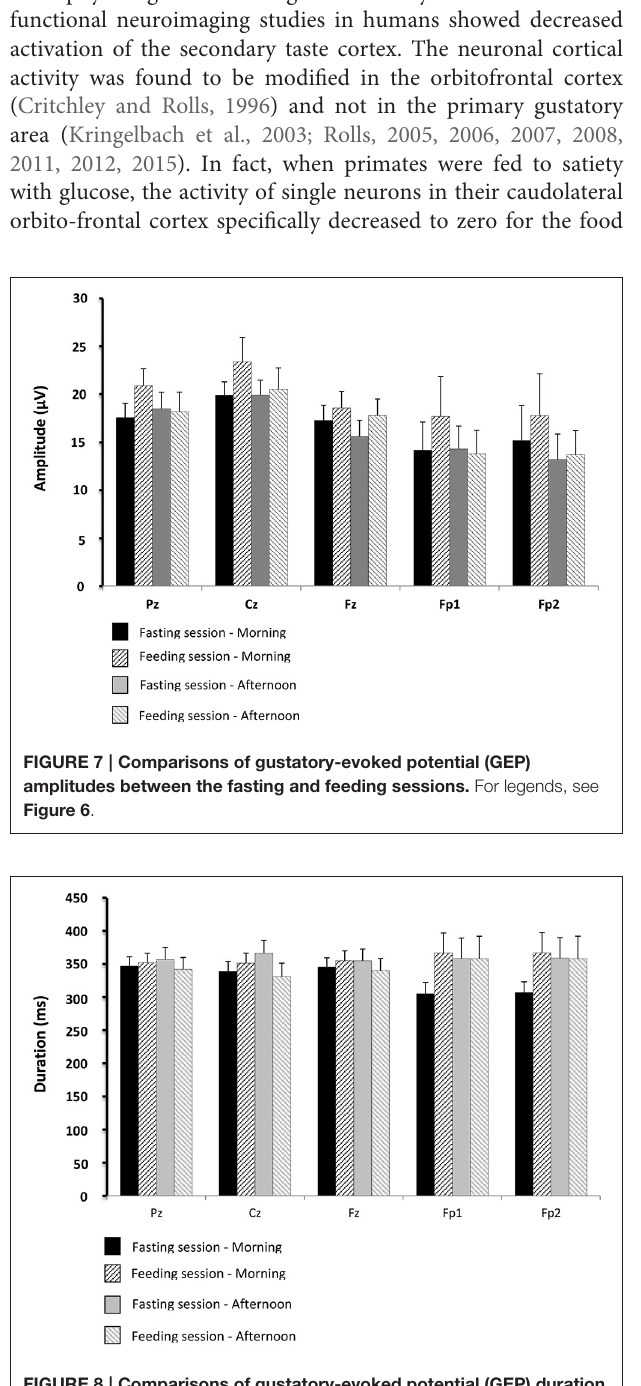
FIGURE 8 | Comparisons of gustatory-evoked potential (GEP) duration between the fasting and feeding sessions. For legends, see Figure 6